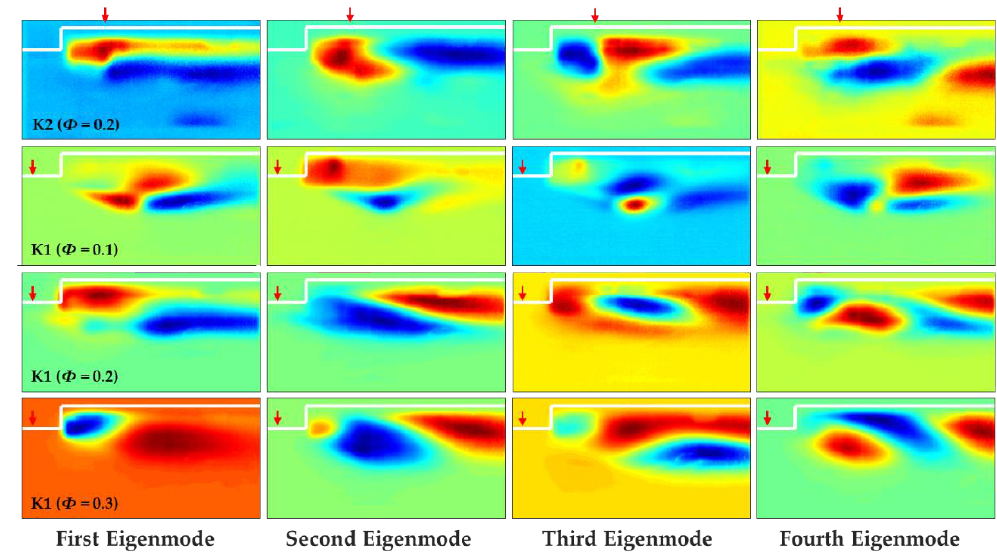
Figure 5. The first four POD modes of chemiluminescence images captured by FBE1.